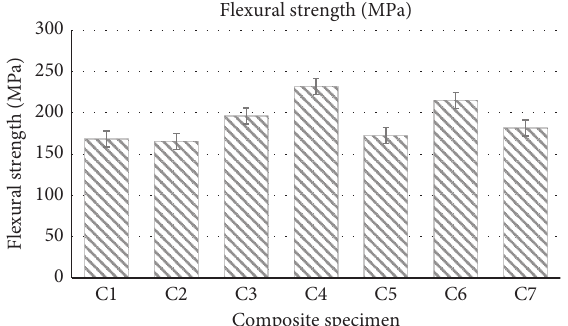
Figure 5: Flexural strength of hybrid and nonhybrid